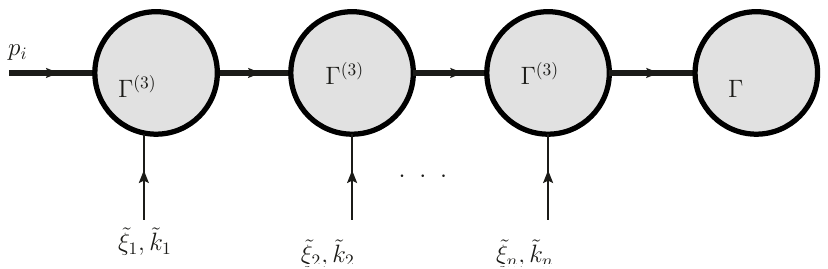
Figure 12 . Diagram with n number of soft particles attached to i ’th leg via three point